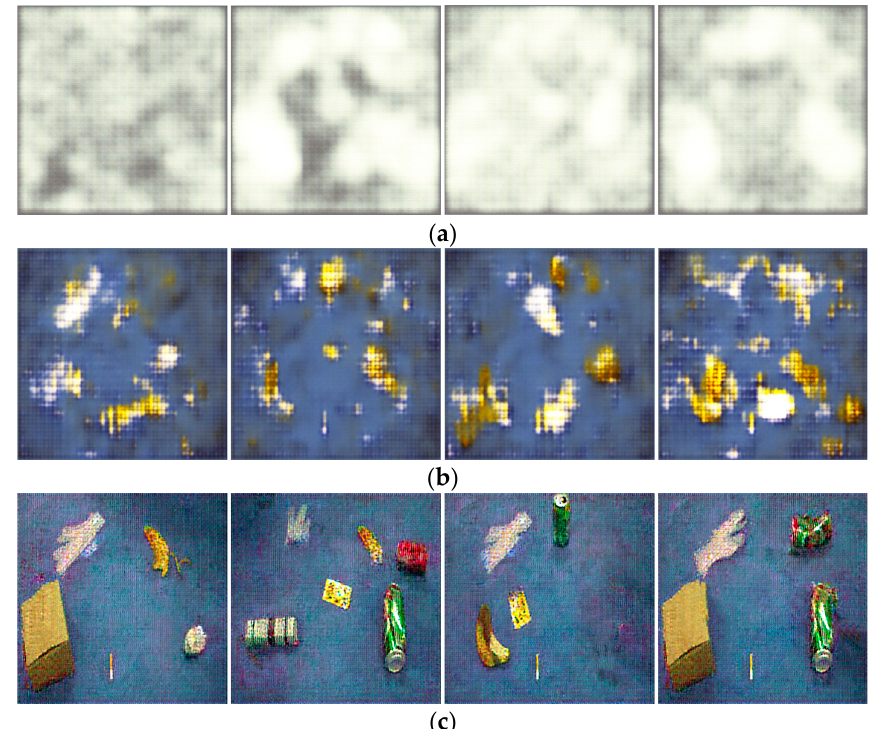
Figure 9. The e ff ect of original DCGAN for generating multi-target waste images under di ff erent Figure 9. The effect of original DCGAN for generating multi-target waste images under different iterations: ( a ) Epoch10; ( b ) Epoch100; and ( c ) Epoch200. iterations: ( a ) Epoch10; ( b ) Epoch100; and ( c ) Epoch200.